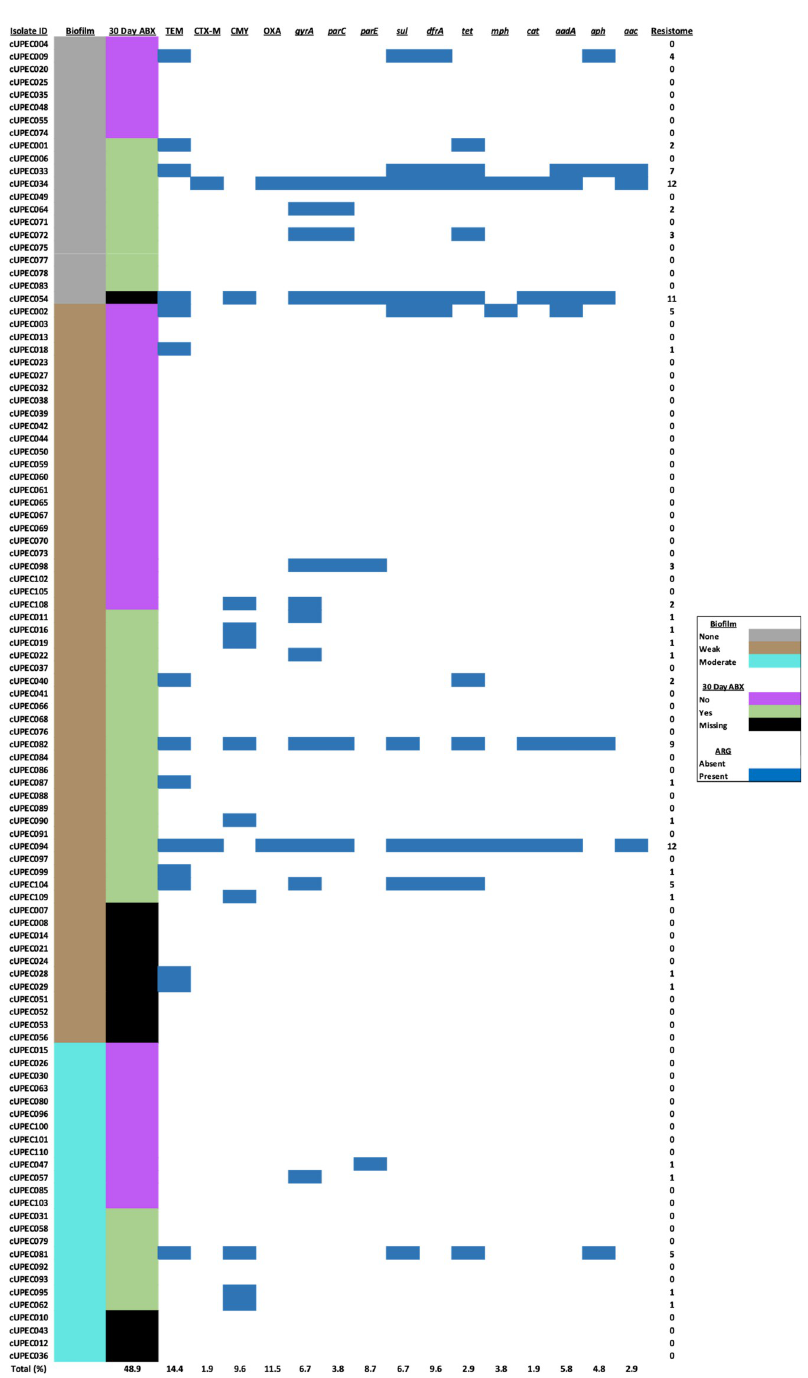
Fig 3. The acquired resistome profile of the 104 canine UPEC isolates. The resistome profiles of UPEC isolates stratified by biofilm formation and 30-day history of antibiotic exposure. Sample prevalence of dogs exposed to antibiotics and resistance genes is presented at the bottom of the figure. The cumulative number of acquired resistance genes in the resistome of each isolate is presented in the furthest right column.